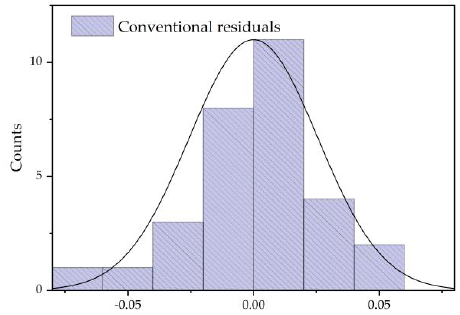
Figure 13. Conventional residual analysis. Table 6. Calculation results of the validation groups.